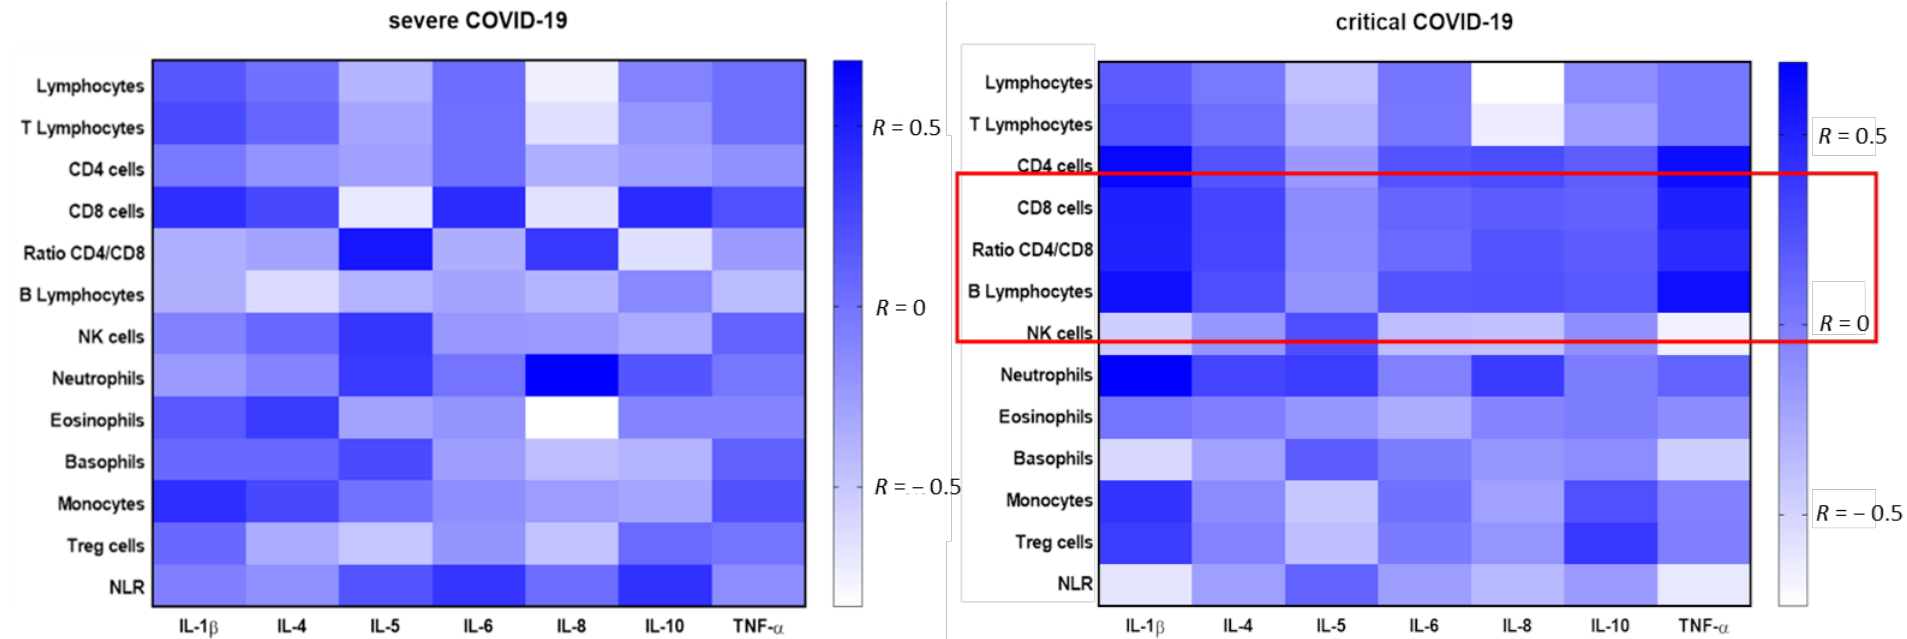
Figure 4. A heatmap of Spearman correlation coefficients for the cytokine levels with leukocytes using multiparameter flow cytometry in severe COVID-19 and critical COVID-19 group. Correlations with an absolute value more than 0.5 are associated with p < 0.05, blue—positive correlations, white—negative correlations. The red line highlights significant positive, strong correlations between the studied parameters in the critical group.